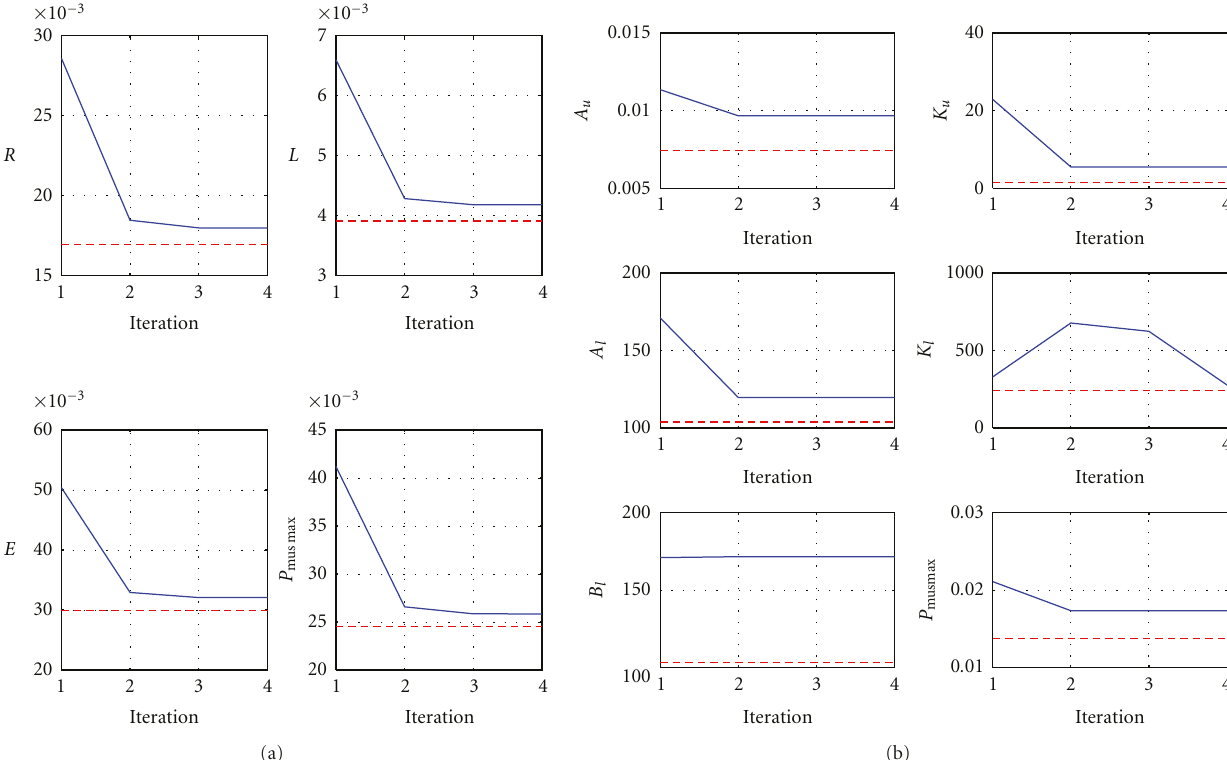
Figure 2: Cramer-Rao Lower Bounds (dotted red line) and estimator variances (black line) versus iteration.